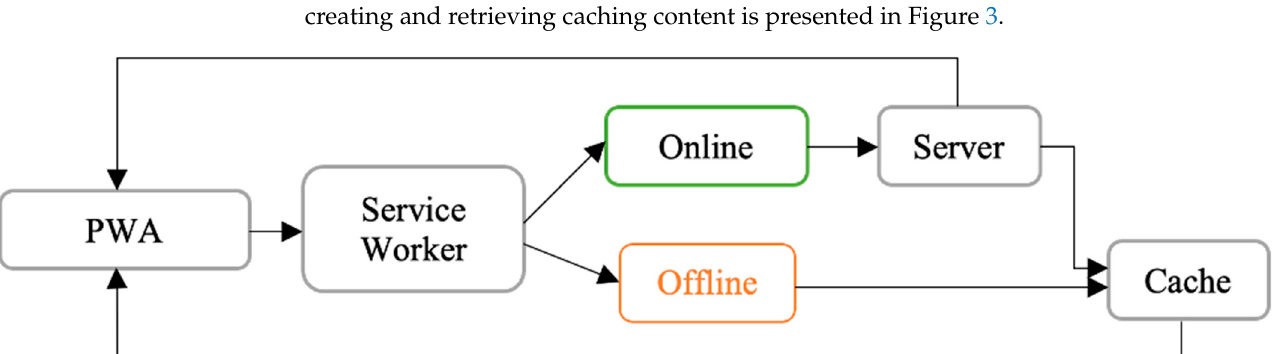
354 Figure 2. Service worker’s lifecycle .